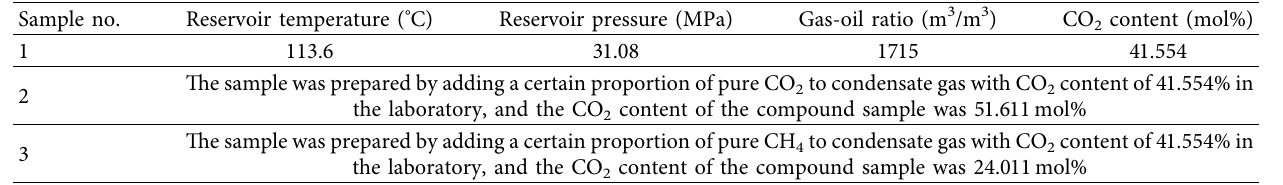
Table 1: Experimental conditions (original reservoir conditions). Sample